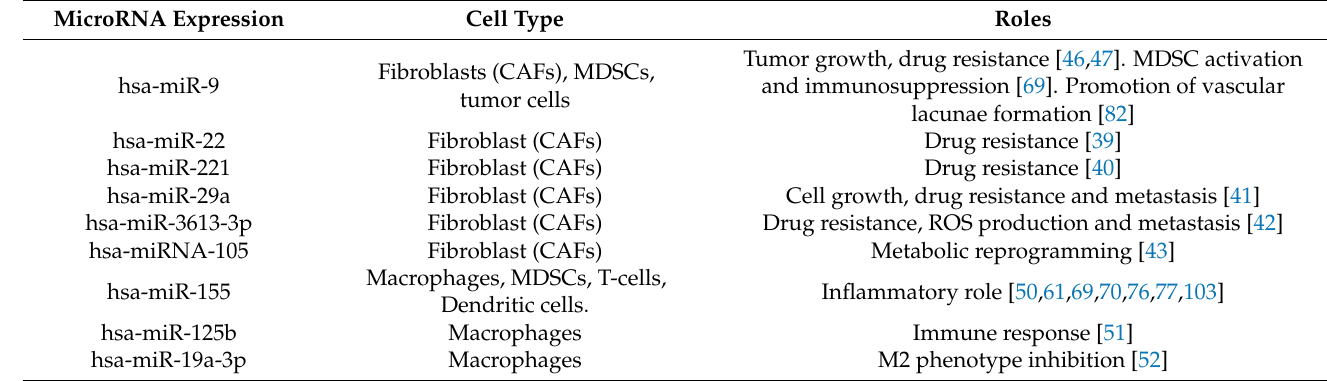
Figure 1. Hypothetical miRNA-based therapy model with a microRNA that, by affecting cancer cells and their environment, has anti-tumoral effects. The relevance of miRNA activity in shaping the breast TME ( left panel), supports the idea of miRNA modulation as a therapeutic strategy. Thus, disrupting aberrant crosstalk and reverting malignant phenotypes would help to overcome or prevent therapy resistance ( right panel). The figure was created with BioRender.com (accessed on 11 June 2021). Table 1. Cell-specific functions of